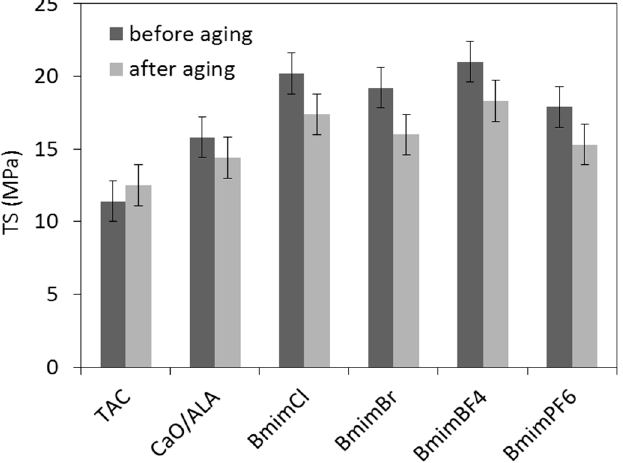
Figure 12. Tensile strength of silica-filled EPM vulcanizates after weather aging.